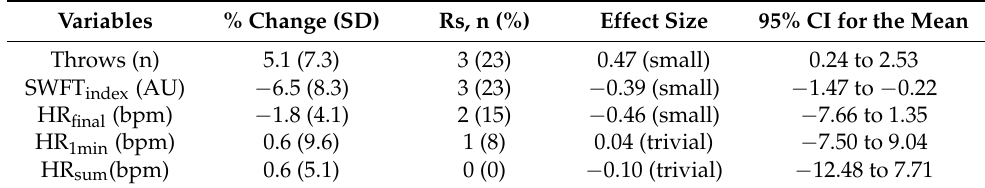
Table 3. Group pre–post change and responders after 6 weeks of multi-component